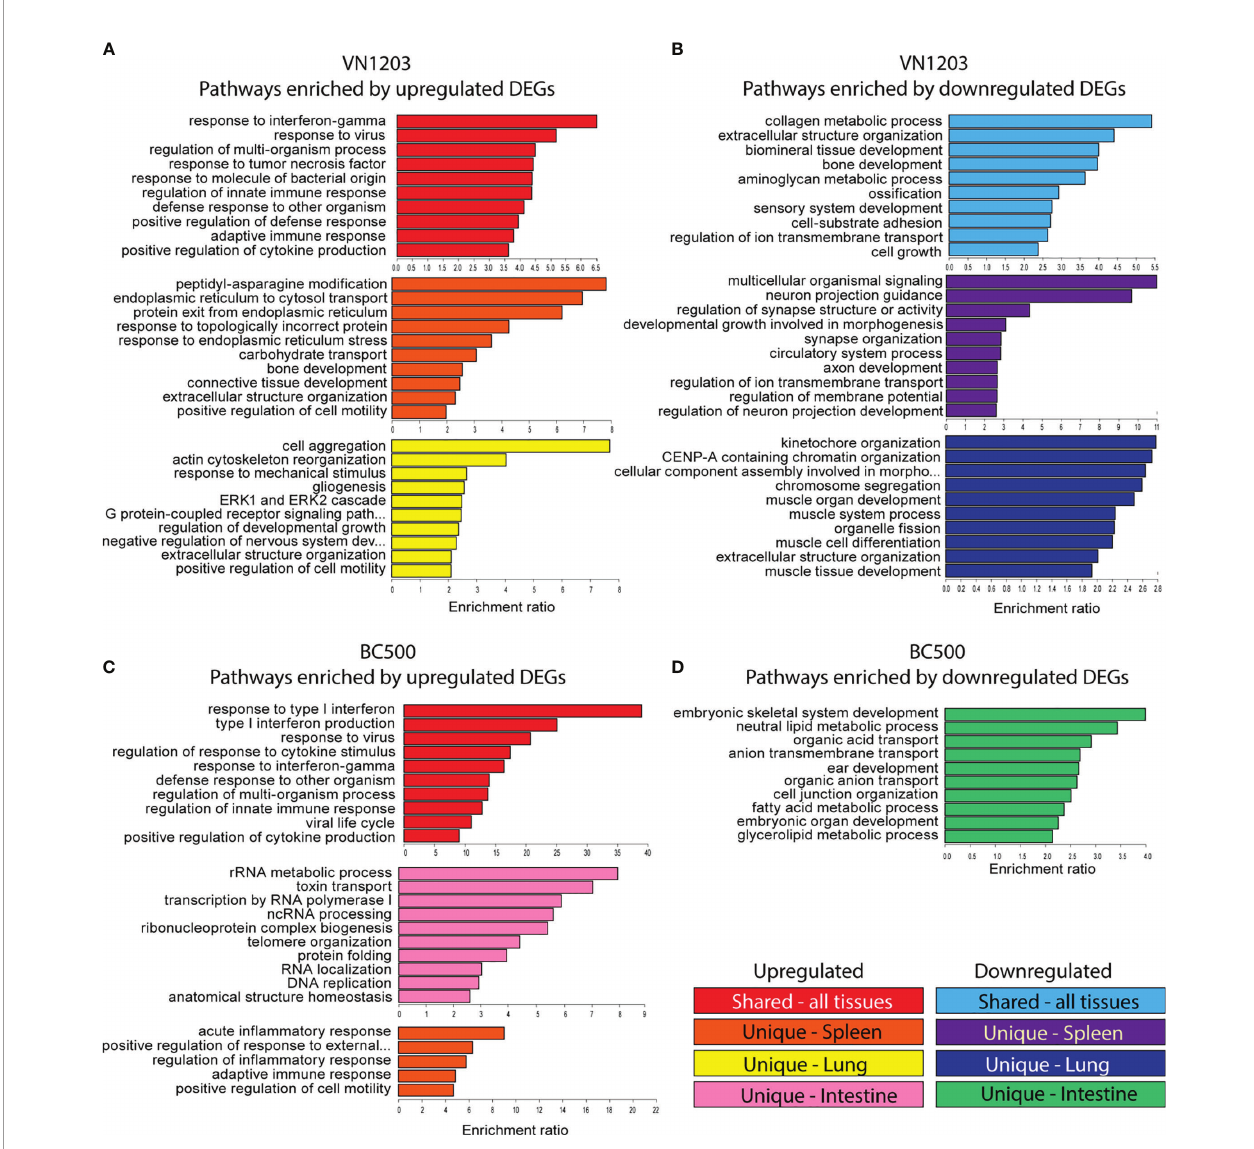
FIGURE 3 | Gene ontology (GO) analysis of common and uniquely differentially expressed transcripts between VN1203 and BC500 infected ducks Differentially expressed genes were assigned up or down regulated based on log2(FC) (upregulated>1, downregulated<-1) lists and were arranged as “ similar between tissues ” , “ unique to spleen ” , “ unique to lung ” or “ unique to intestine ” . For ducks infected with VN1203, the top 10 most highly enriched terms in the GO biological function category were graphed for upregulated genes (A) and downregulated genes (B) . For ducks infected with BC500, the top 10 most highly enriched terms derived from upregulated genes (C) or downregulated genes (D) were identi fi ed and enrichment ratio for each term is